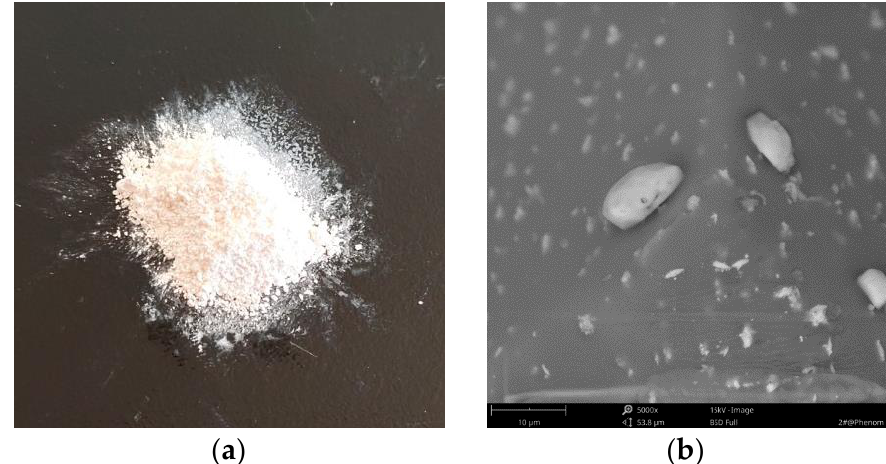
Figure 2. Images of nano TiO 2 /CaCO 3 materials: ( a ) appearance; ( b ) SEM images (5000 × ).